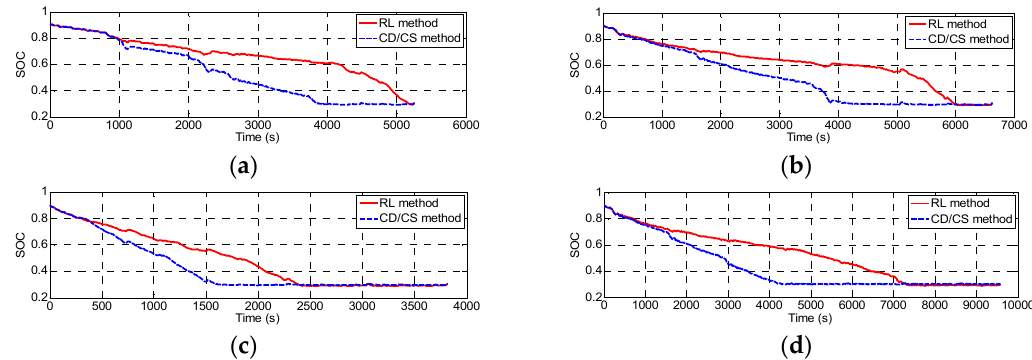
Figure 11. SOC comparison of driving cycles. ( a ) Cycle 1; ( b ) Cycle 2; ( c ) Cycle 3; and ( d ) Cycle 6. Appl. Sci. 2018 , 8 , x FOR PEER REVIEW